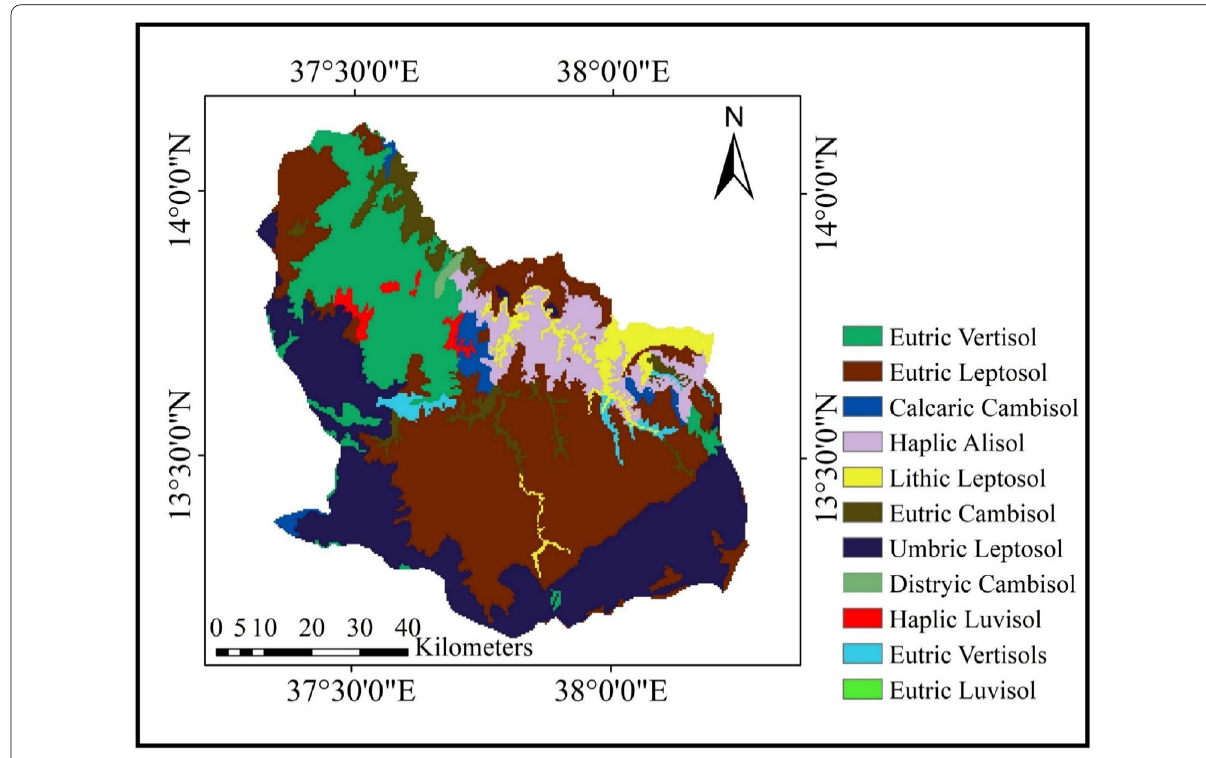
Fig. 2 Soil types found in Zarima